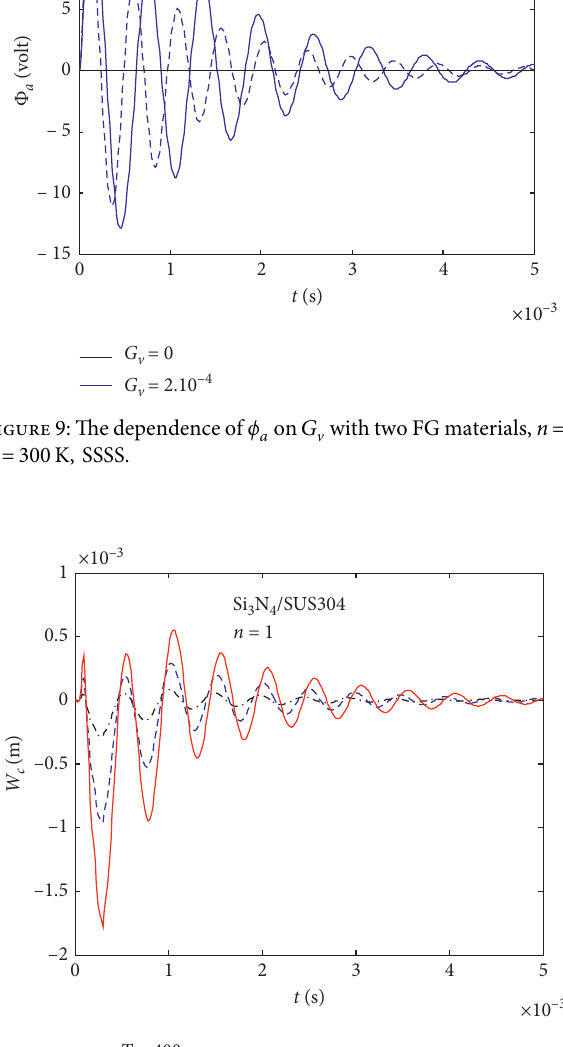
G v with two FG materials, n s on